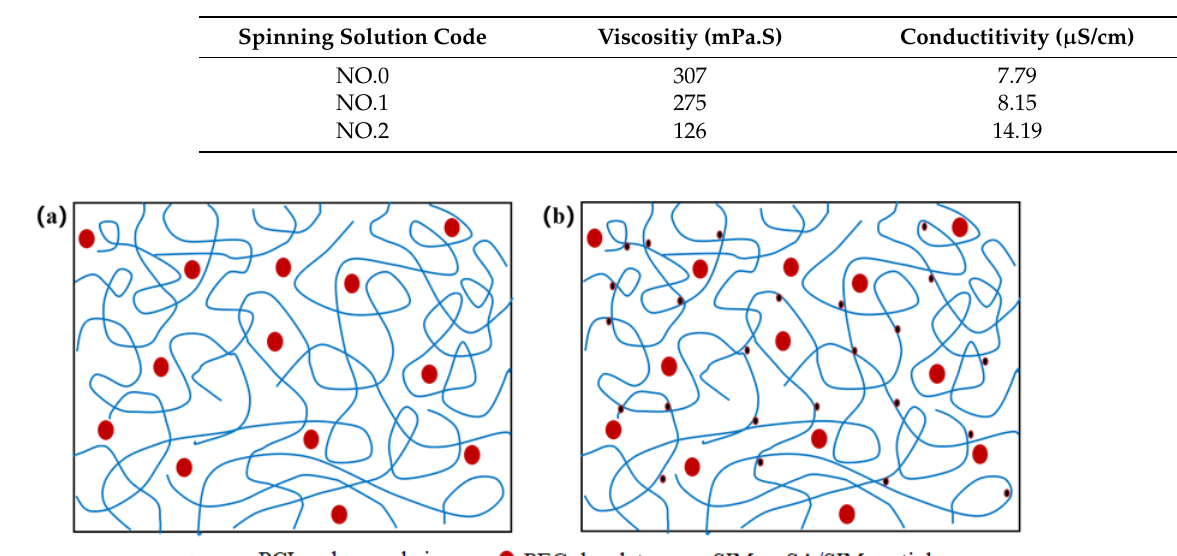
Figure 1. Molecular chain entanglement and molecular diagram in different spinning solutions (NO.0 ( a ), NO. 1 or NO.2 ( b )).